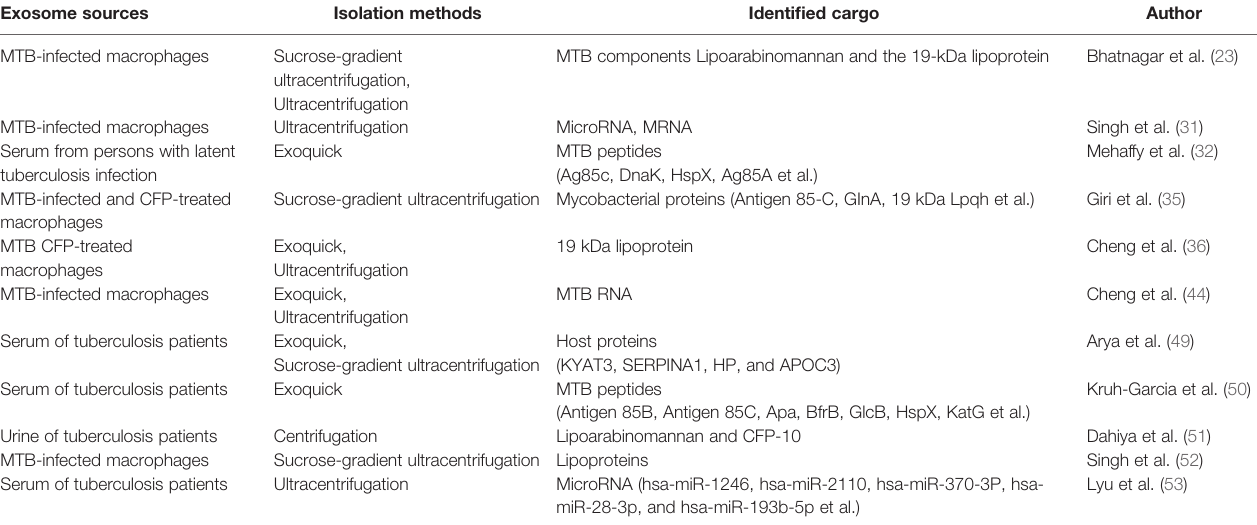
TABLE 1 | Summary of the exosome sources, different isolation methods, and different culprit cargo from the studies. Exosome